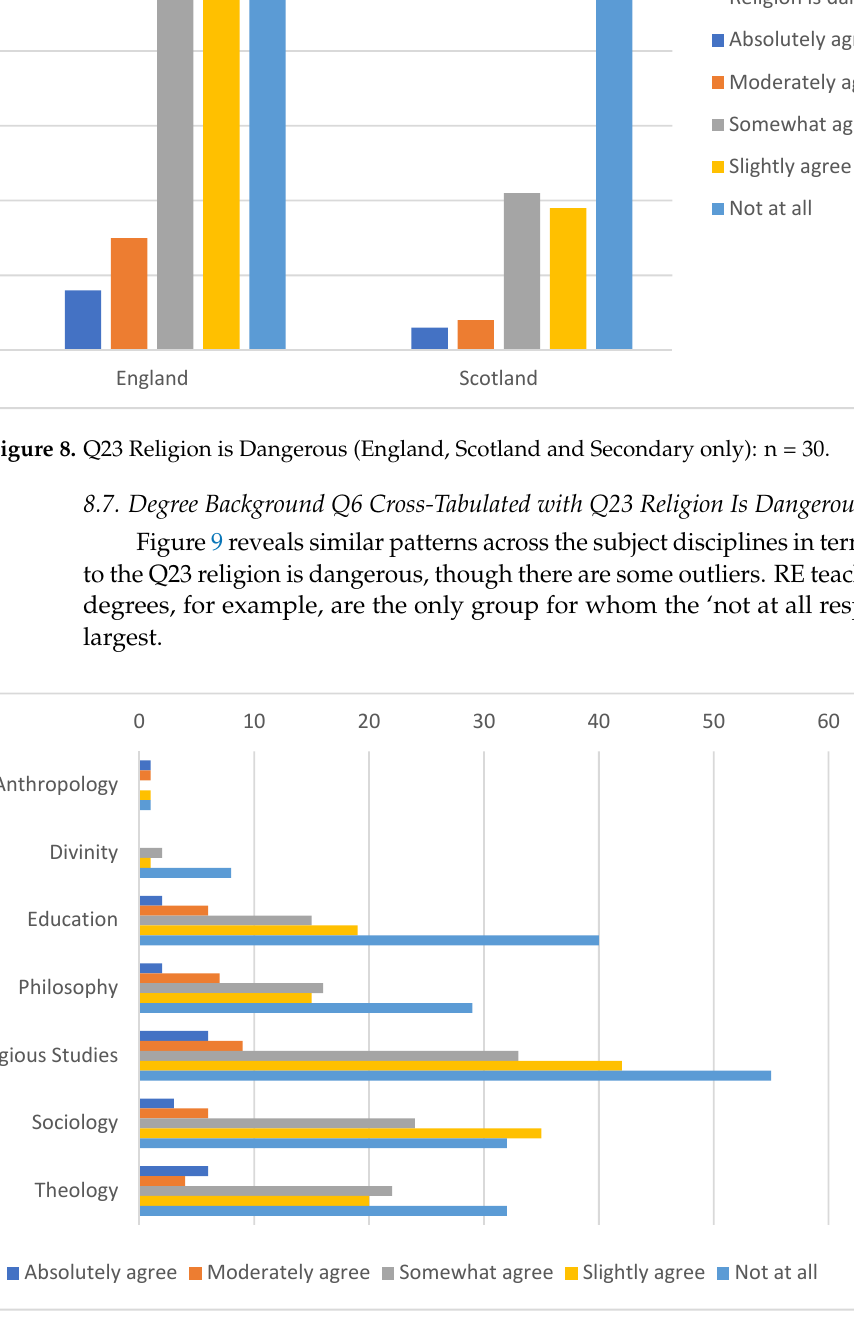
Figure 9. Cross-tabulation of Q6 degree background and Q23 religion is dangerous (England, Scotland and Secondary only): n =